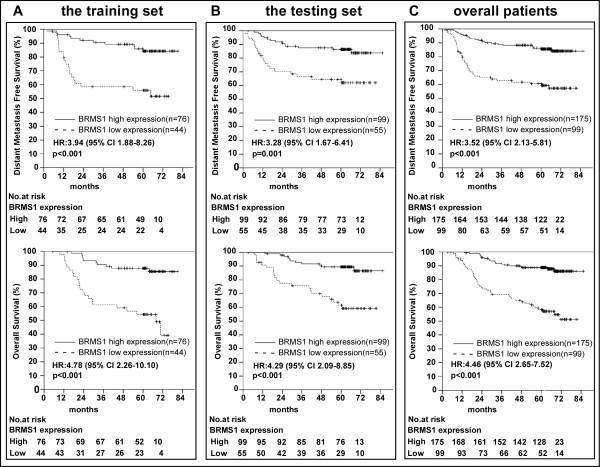
Survival analysis of BRMS1 expression in the training set, testing set and overall patient population. (A) Low BRMS1 expression was correlated with poor distant metastasis-free survival (upper in A) and overall survival (lower in A) in the training cohort. These results were validated in the testing cohort (B) and overall patient population (C). HR: hazard ratio; CI: confidence interval. The HR values were calculated using a univariate Cox regression analysis, and the p values were calculated using the log-rank test.